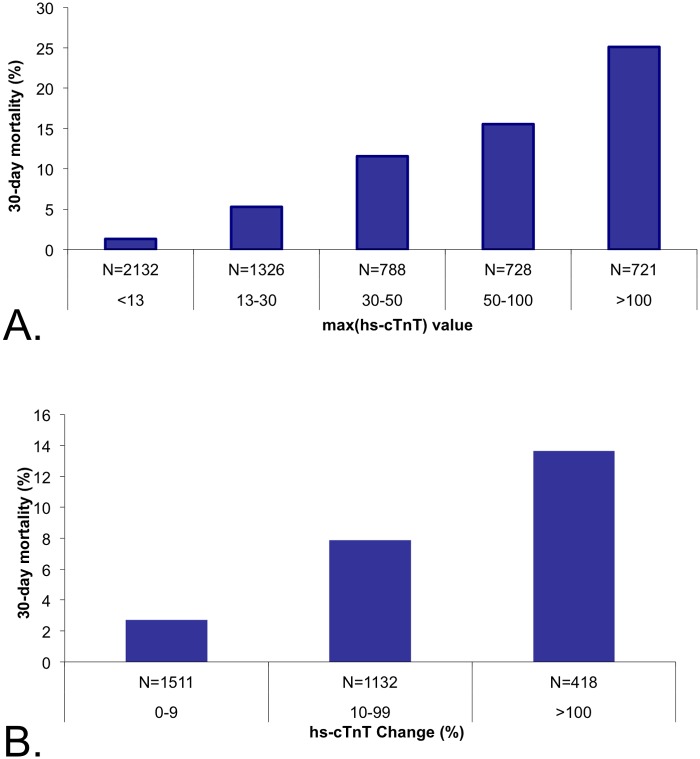
30-day mortality by high sensitivity troponin levels.Univariate analysis showed that maximal high sensitivity troponin levels (A) as well as high sensitivity troponin dynamics correlated with early patient death (p<0.0001 for both).